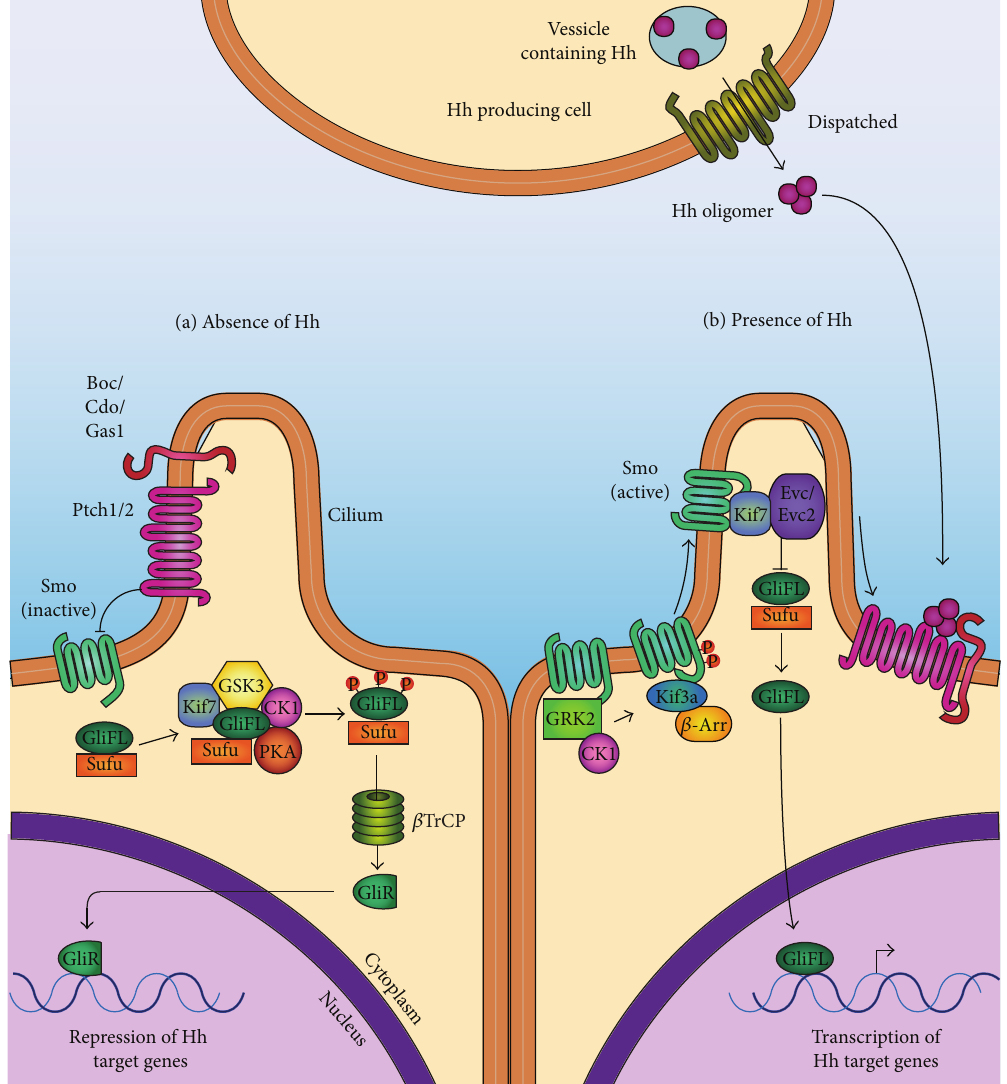
Figure 2: Hh signalling in vertebrates. (a) In the absence of Hh, the Hh receptor, Ptch, represses Smo. Sufu binds to the Gli-FL transcription factors, sequestering them in the cytoplasm. Sufu and Kif7 then mediate the phosphorylation of Gli-FL by recruiting PKA, GSK3 𝛽 , and CK1 𝛼 . This signals for the proteolytic cleavage of Gli-FL by 𝛽 TrCP, resulting in the degradation of the C-terminal and formation of Gli-R. Gli-R then localizes to the nucleus and represses the expression of Hh target genes. (b) In the presence of Hh, Hh binds to Ptch, antagonizing its repressor function. Smo becomes phosphorylated by CK1 𝛼 and GRK2 and promotes 𝛽 -arrestin and Kif3a-dependent trafficking of Smo to the cilium. With the aid of Kif7, Smo then promotes the disassembly of the Sufu-Gli-FL complex. Gli-FL then localizes to the nucleus to activate target gene expression and is later degraded by